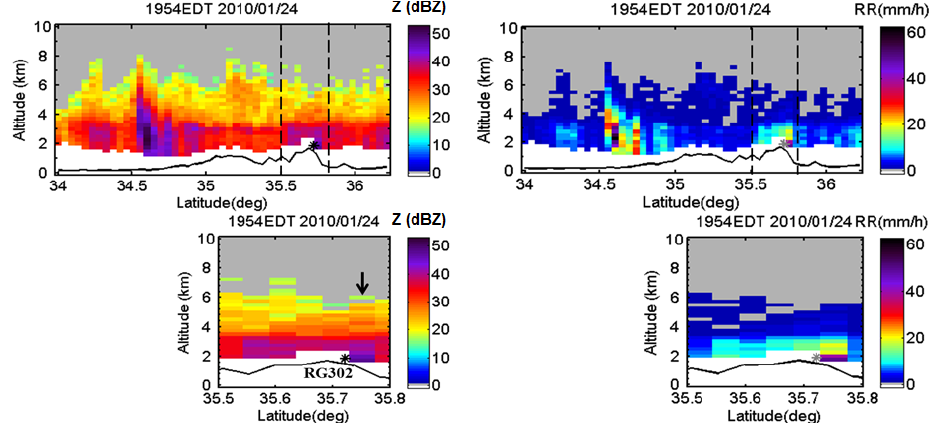
Figure 12. Cross section of reflectivity ( Z ) and rain rate estimates (RR) from TRMM 2A25 for a selected case of incorrect false alarm determination at 19:54EDT on 24 January 2010. The top row shows an overpass cross section. The bottom row shows the cross section between the two dashed vertical lines in the top row plots. Asterisks denote the position of RG302, and the color in the right panel is consistent with the measured rain rate. The black arrow identifies the PR profile used to make the error determination. Ground-clutter flags are shown in white. The black continuous line represents the